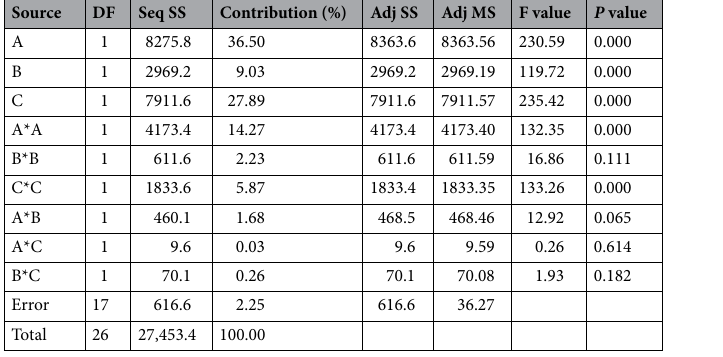
Table 5. ANOVA on ultimate tensile strength